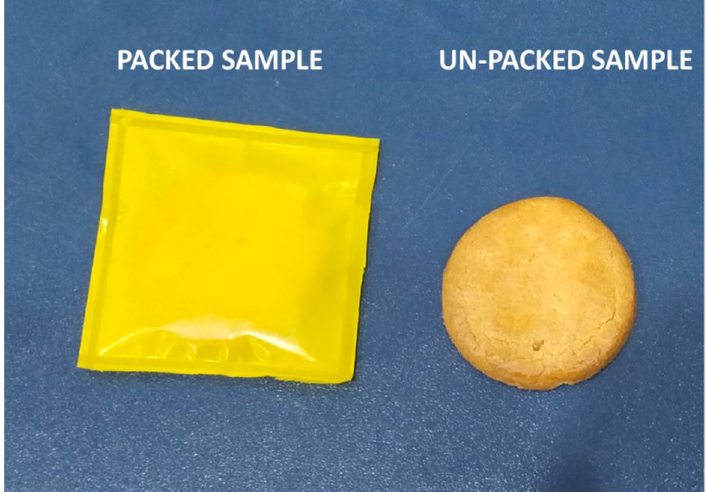
Figure 11. Pictorial representation of a biscuit packed in the G+CS+Y film and an unpacked biscuit sample.